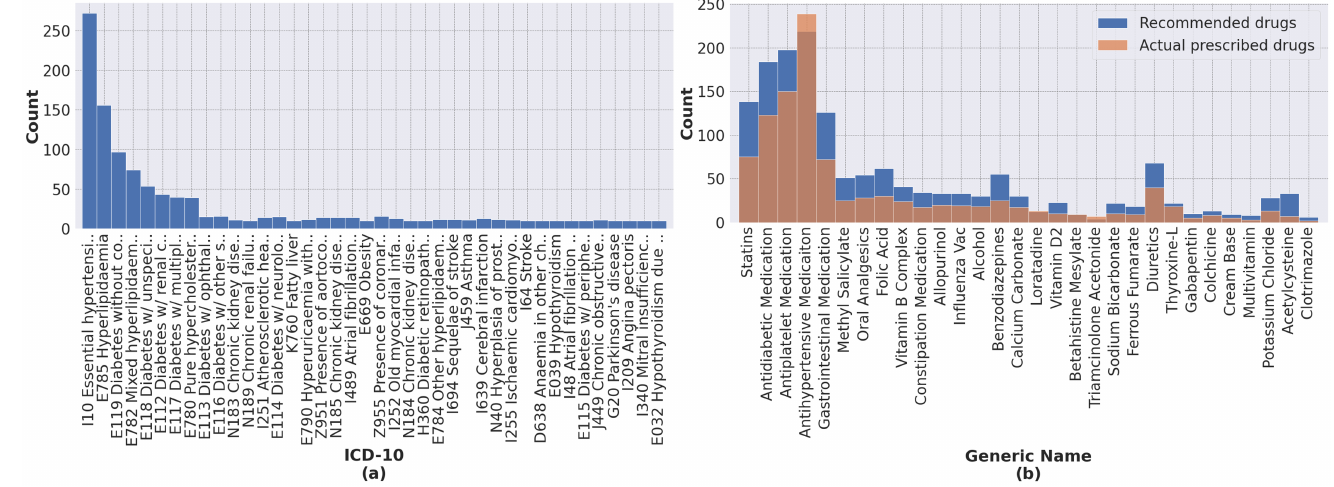
Figure 6. Distribution of ( a ) ICD-10 codes and ( b ) recommended drugs in our physician evaluation set.